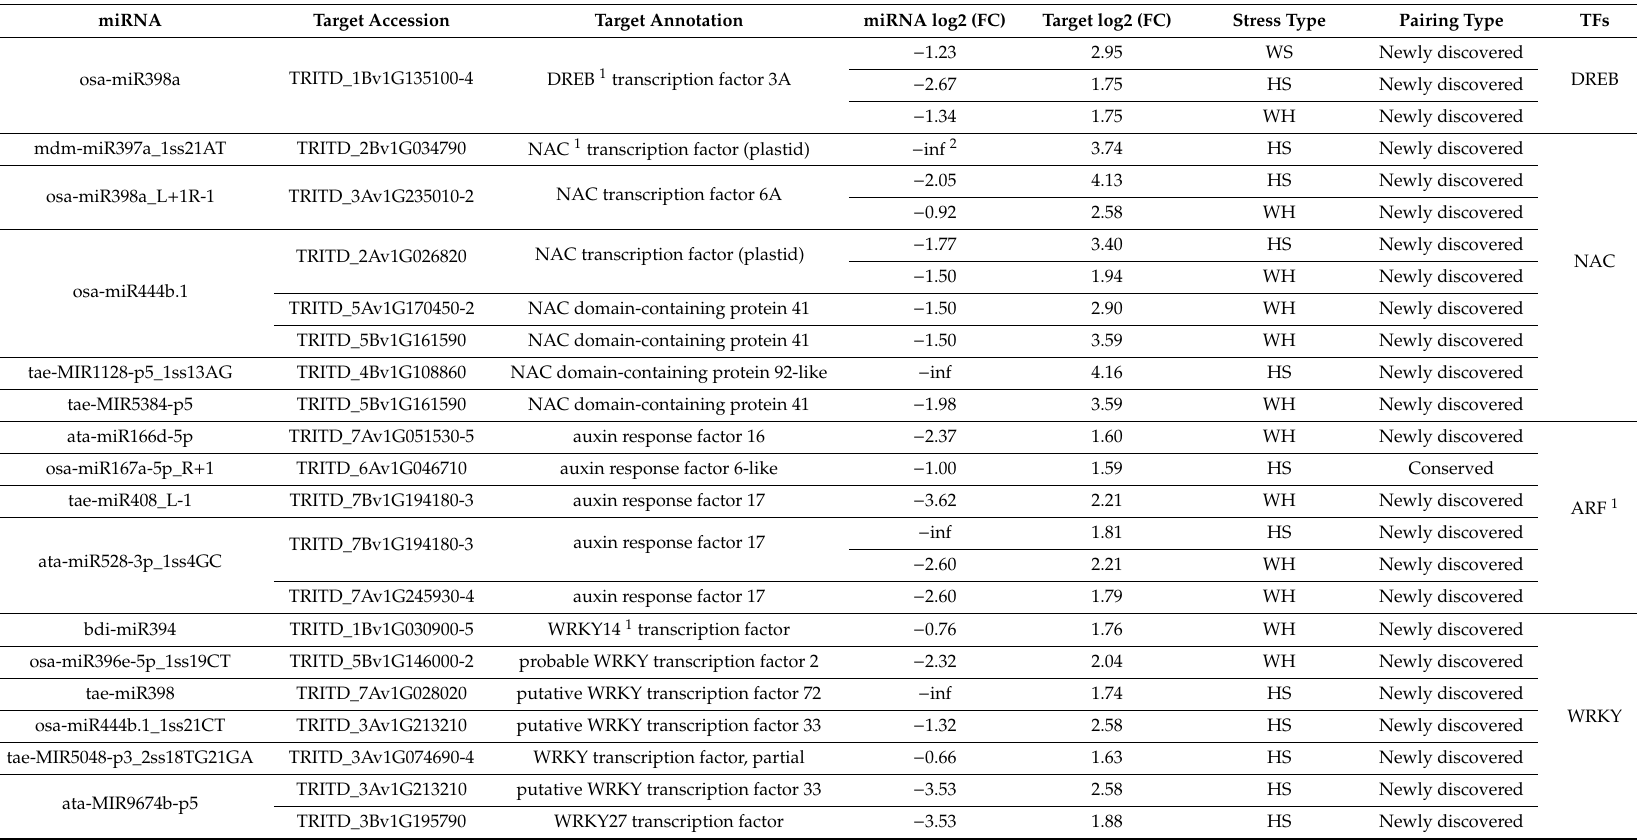
Table 2. Examples of stress-responsive microRNA (miRNA)-TF (transcription factor) pairs with antagonistic regulatory patterns in DBA Aurora. miRNA log2(FC) shows the log2(fold-change) value of the miRNA expression under stress vs. control. Target log2(FC) shows the log2(fold-change) value of the mRNA expression under stress vs. control. Pairing type indicates whether the miRNA-mRNA is newly discovered or